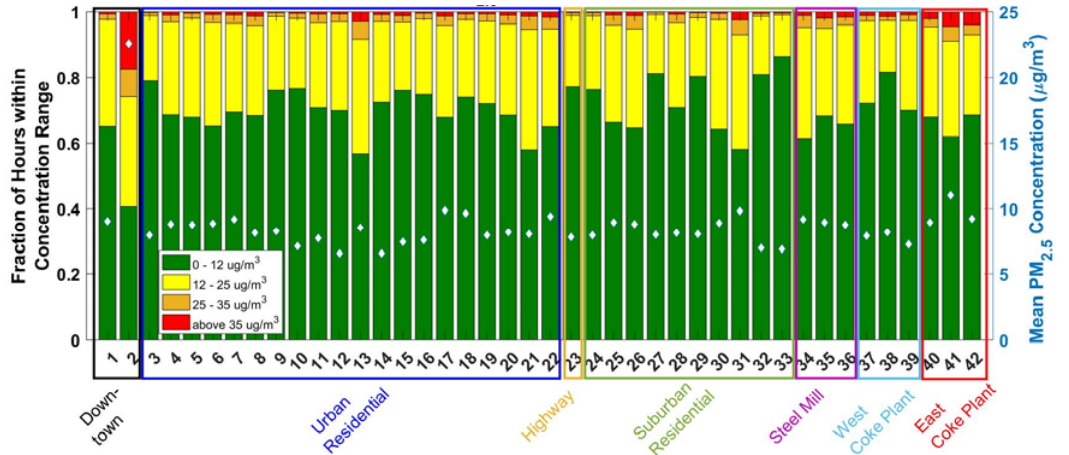
Figure 3. Average PM 2.5 concentrations across the RAMP network. The bars show the fraction of hourly averaged PM 2.5 measurements within each of four concentration ranges based on EPA and WHO regulatory cutoffs. Mean PM 2.5 concentration is indicated within each bar as a white diamond.